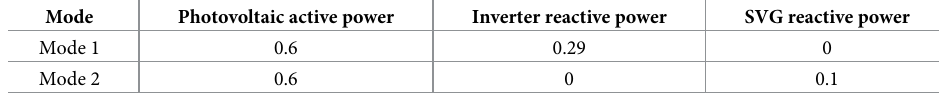
Table 3. Photovoltaic system reactive support combination unit: Pu.